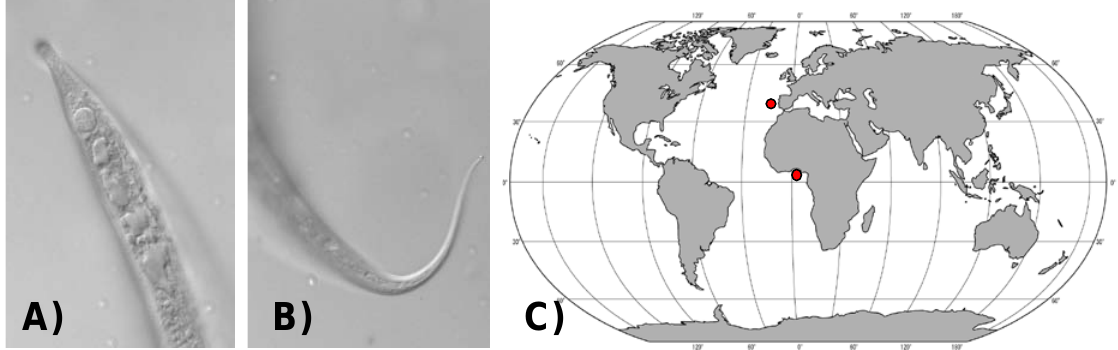
Figure 5. Pictorial key for Manganonema sp. 3 ( putative species ) ( A–C ) and Manganonema sp. 4 ( D–F ) with the representation of the anterior and posterior ends, geographical distribution (red circles indicate records in the present study, green circles indicate records available in literature) and short diagnosis of each species. Reported are ratio a = body length divided by maximum body diameter, b = body length divided by pharyngeal length, c = body length divided by tail length, c' = tail length divided by anal body diameter, cbd = corresponding body